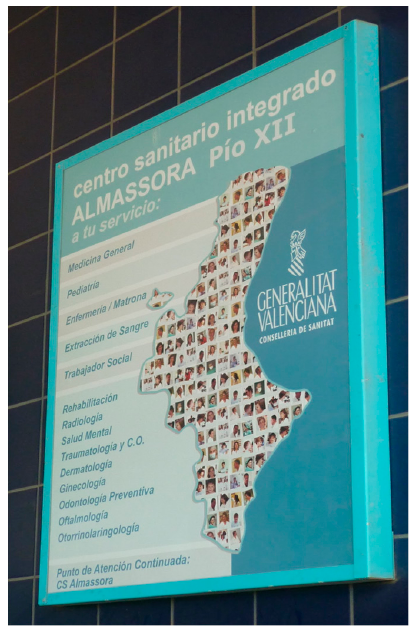
Figure 14. Almazora: Spanish-only sign on an outpatient clinic.